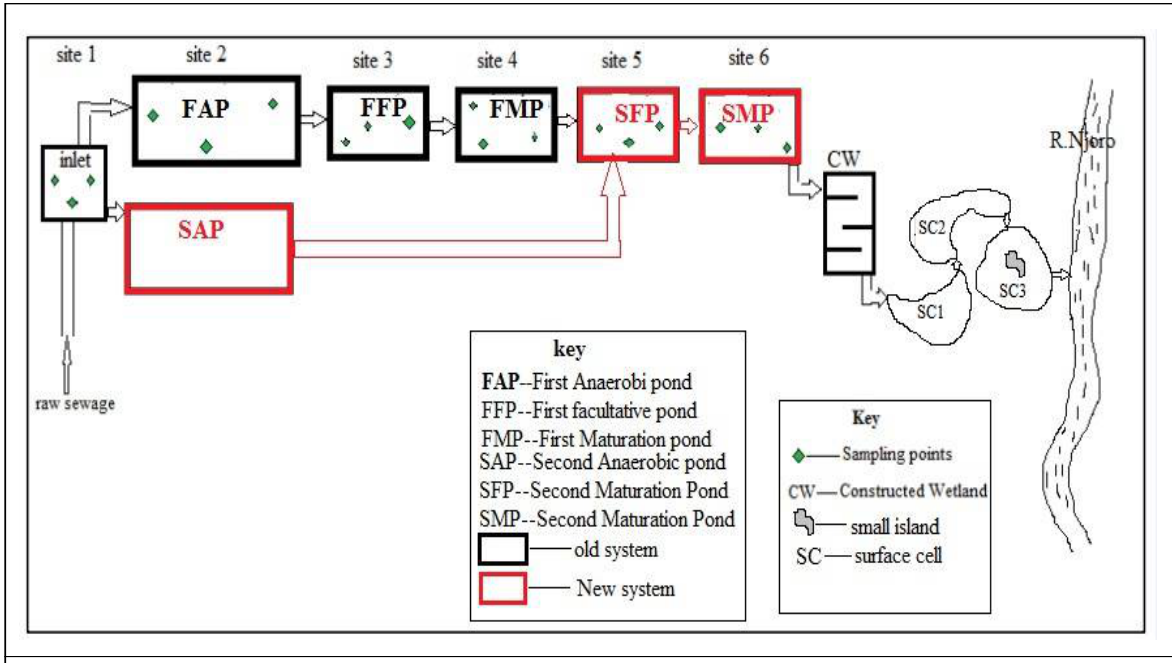
Figure 2: Schematic diagram showing design of the WSPs at